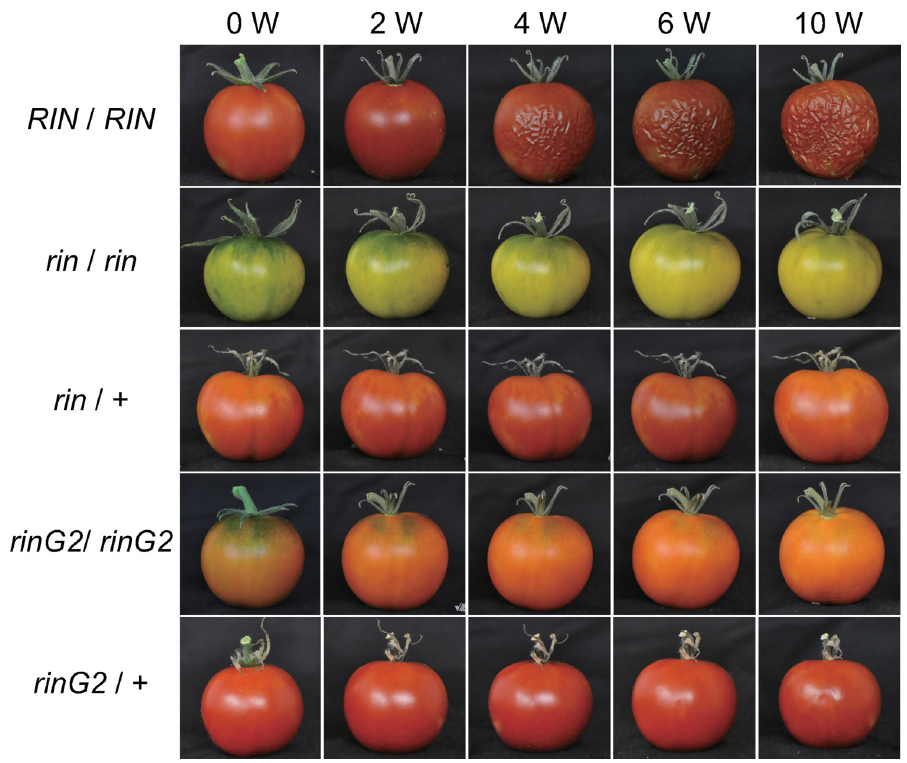
Fig 2. Heterozygous effects of rinG2 on fruit shelf life. Fruits were harvested at 7 days after the breaker stage (0 W) and stored at 25˚C. (Fig 4). Polygalacturonase2a ( PG2a ) encodes an enzyme that hydrolyzes α -1,4 glycosidic bonds within pectins and is strongly induced during ripening [4, 34]. PG2a expression was correlated to the rate of fruit softening in all lines examined. Wild-type fruits showed intense PG2a expression during ripening, whereas its expression was strongly repressed in the rin/rin and rinG2/rinG2 fruits. Both the rin/+ and rinG2/+ lines showed ripening-specific upregula- tion of PG2a , but the PG2a transcript level in these lines was approximately 39% and 34% of the wild type at the B+4 stage, and 34% and 25% of wild type at the B+7 stage, respectively. Pectate lyase (PL), which depolymerizes pectin via a β -elimination mechanism, is a major contributor to tomato fruit softening [35, 36]. PL expression was observed specifically during ripening in wild-type fruits but was strongly repressed in rin/rin fruits. Unlike PG2a , PL was expressed at only a slightly lower level in rinG2/rinG2 fruits and at a comparable level in both heterozygous lines vs. the wild type. Cellulase 2 ( Cel2 ), encoding an endo- β -1,4-glucanese, was specifically expressed during ripening in wild-type fruits. This gene was expressed at signifi- cantly lower levels in the homozygous and heterozygous rin and rinG2 fruits compared to the wild type at the B+4 stage; among these, the rinG2/+ fruits showed slightly higher expression at the B+7 stage compared to the other fruits.